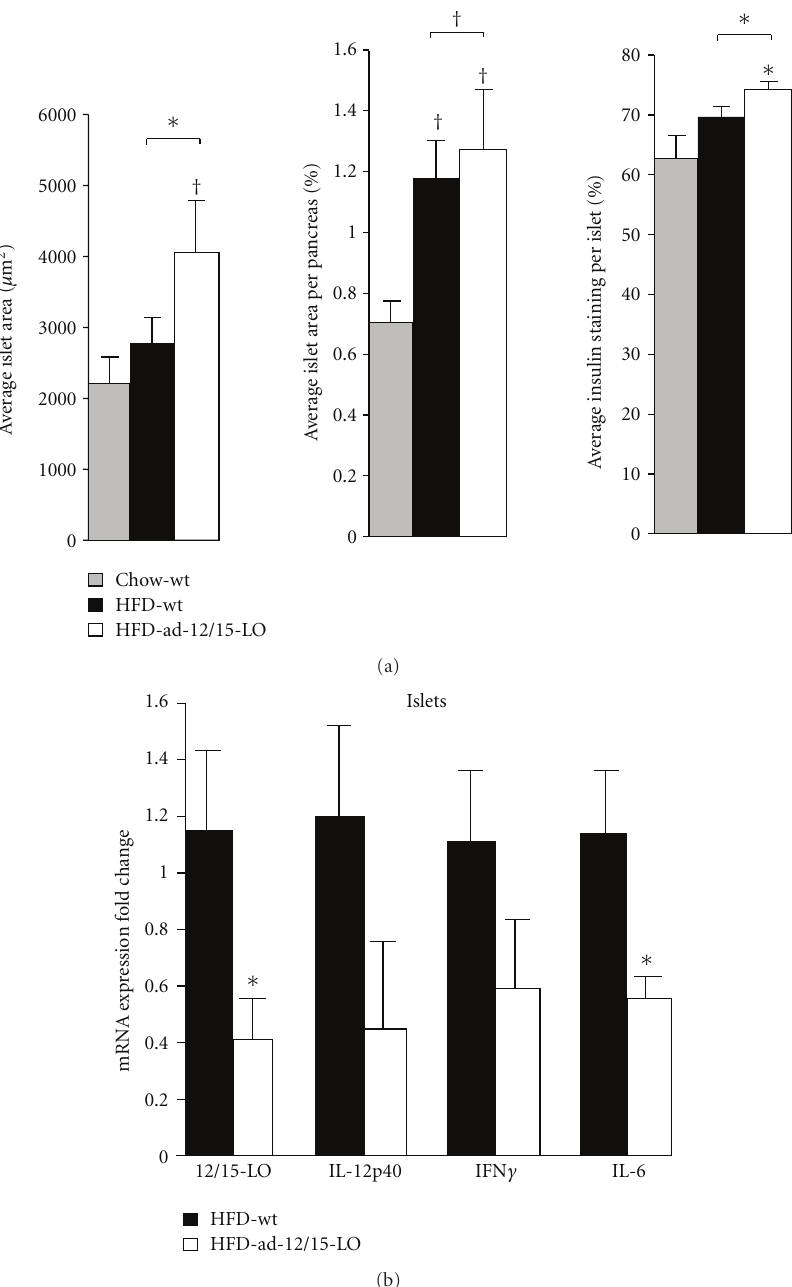
Figure 5: Fat-specific 12/15-LO-deficient mice exhibit improvements in pancreatic islet health. (a) Immunohistochemistry for insulin expression on pancreatic sections from mice after the 16-week feeding regimen was analyzed for average islet area, average islet area per pancreas area, and average insulin staining per islet; n = 3–5; Chow: chow diet; HFD: high-fat diet; wt: wild type 12/15 - LO loxP/loxP . (b) mRNA measurements of key proinflammatory genes were examined by RT-PCR in isolated pancreatic islets from mice after the 16-week feeding regimen; n = 6–8; HFD: high-fat diet; wt: wild type C57BL/6J. All mRNA data were normalized to total actin, and the fold changes in expression were calculated relative to control. All data represent the means ± SEM. ∗ P < 0 . 05 and † P < 0 . 02 versus control, unless otherwise